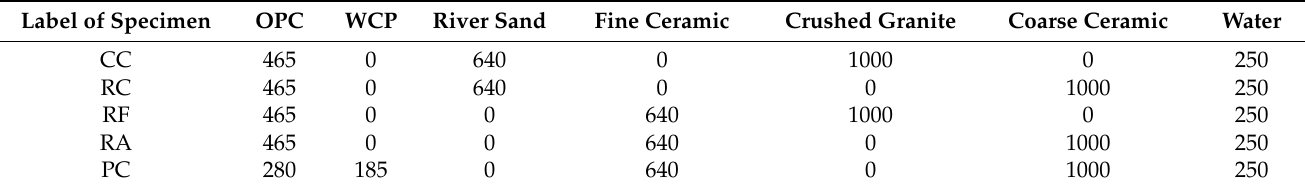
Table 2. Mix proportions of different concrete mixes.